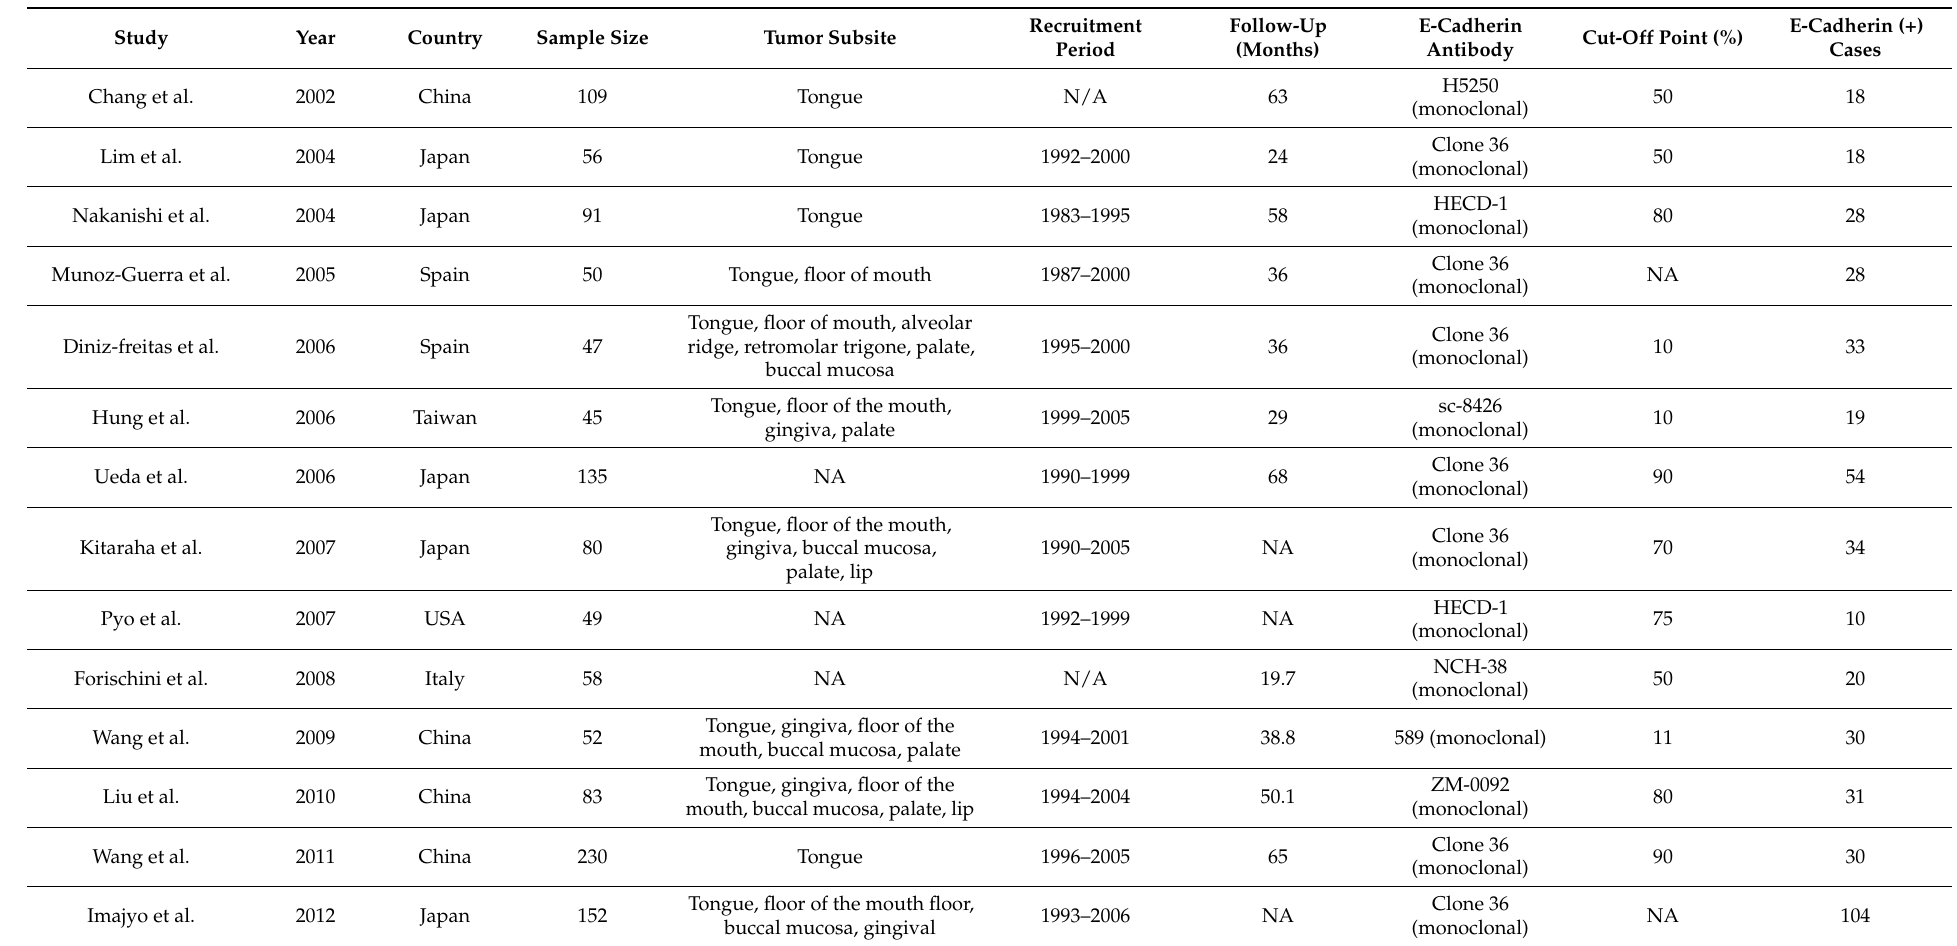
Table 1. General characteristics of included